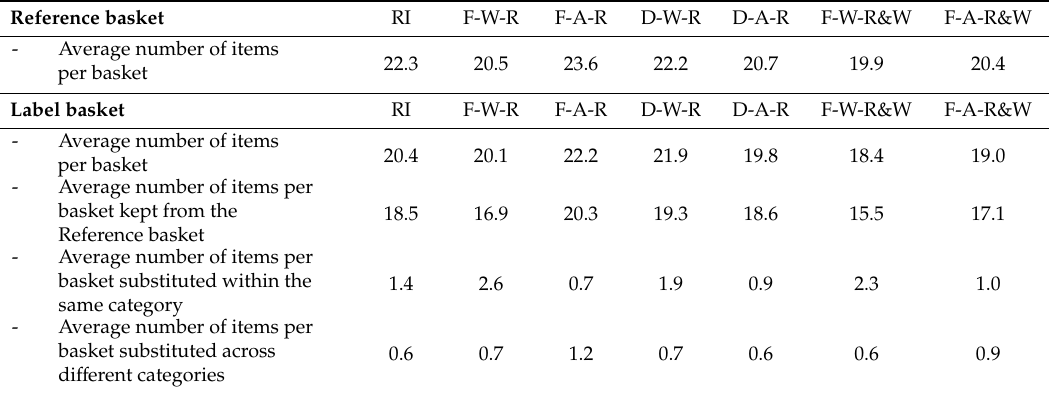
Table 8. Average number of items per basket in the reference basket and in the label basked according to the seven